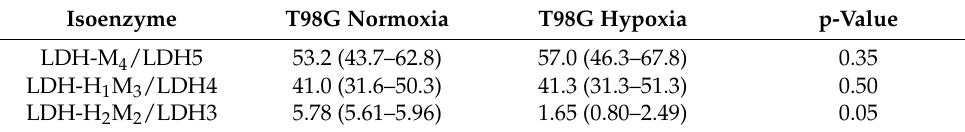
Figure 3. Native gel electrophoresis and densitometry. ( a ) From left to right, lanes were loaded with 5 µ L (0.03 U) purified lyophilized rabbit skeletal muscle LDH-M (RM), 5 µ L (0.02 U) purified lyophilized porcine heart LDH-H (PH), and 12 µ g total protein mouse cerebellum extract (MCB), and 12 µ g protein from extracted T98G cells grown in normoxia and hypoxia, respectively. ( b ) Densitome- try was performed using ImageJ software (version 1.53) and areas under the curve were calculated for each band, corresponding to LDH isoform activity. A calibration curve representing background signal was subtracted from each of the control and experimental lane signals. Table 6. LDH isoenzyme activity, expressed as % of total LDH